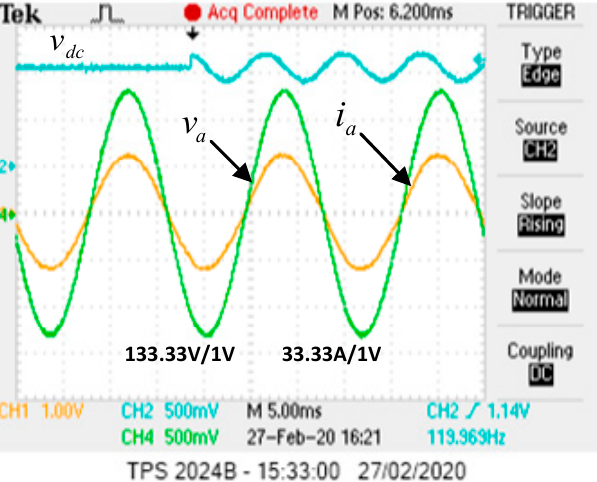
Figure 20. Voltage and current for phase A during f = 61 Hz. Pref = 10 kW and Qref = 0 kVAr.